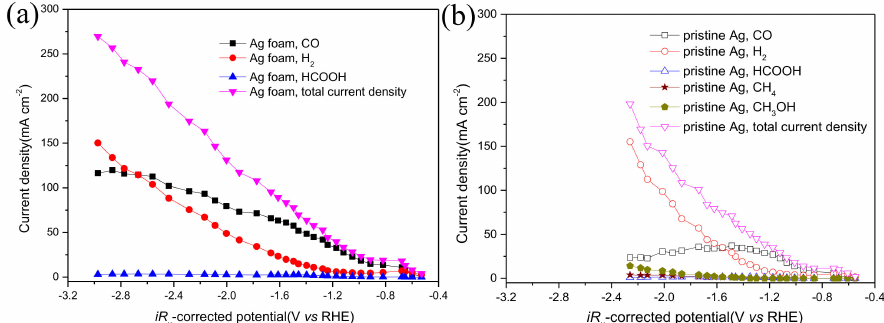
Figure 7. Partial current density of each reduction product for Ag foam ( a ) and pristine Ag ( b ) electrodes as a function of potential. Experimental conditions: anolyte, 0.5 M NaOH; catholyte, CO 2 -saturated 0.1 M KHCO 3 ; 25 ◦ C.